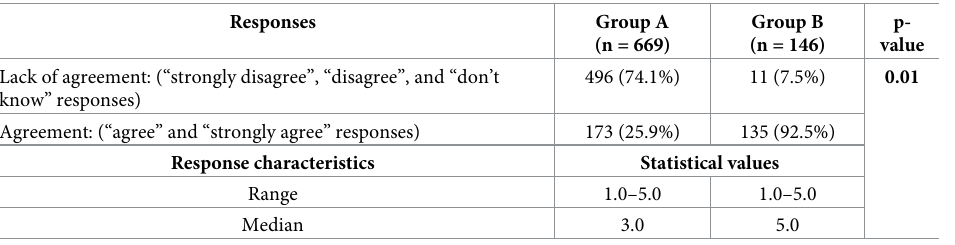
Table 2. Responses of the Polish (group A) and the American (group B) nurses to the question: “Do you think that nurses are adequately prepared to independently report ADRs and